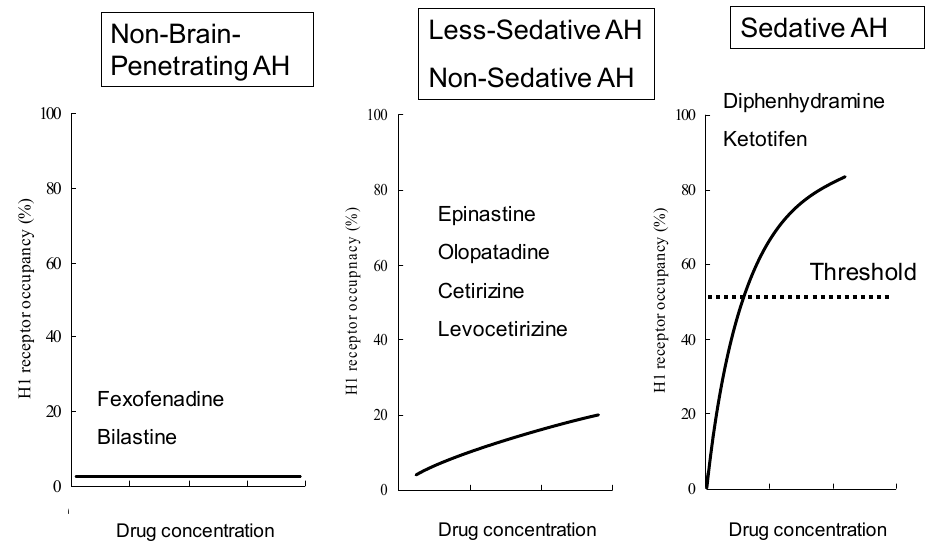
Figure 4. A new classification of antihistamines based on brain histamine H 1 receptor occupancy. Antihistamines can be classified into non-sedating, less-sedating, and sedating groups based on the H 1 RO and mean plasma concentration of the drugs measured during positron emission tomography, as previously reported [9,29]. In this figure, the concept of “non-brain-penetrating” [32] is included. The H 1 ROs of non-brain-penetrating antihistamines are nearly zero and not correlated to the plasma concentrations of the drugs. The H 1 ROs of non-sedating and less-sedating antihistamines, in the range of up to 20% (for non-sedating) or 50% (for less-sedating), are proportional to some degree to the plasma concentrations of the drugs and have increased brain penetration. Sedative antihistamines rapidly penetrate the brain and show 50% or more H 1 RO, associated with increasing plasma drug concentrations. AH, antihistamines. (Modified based on [9].)